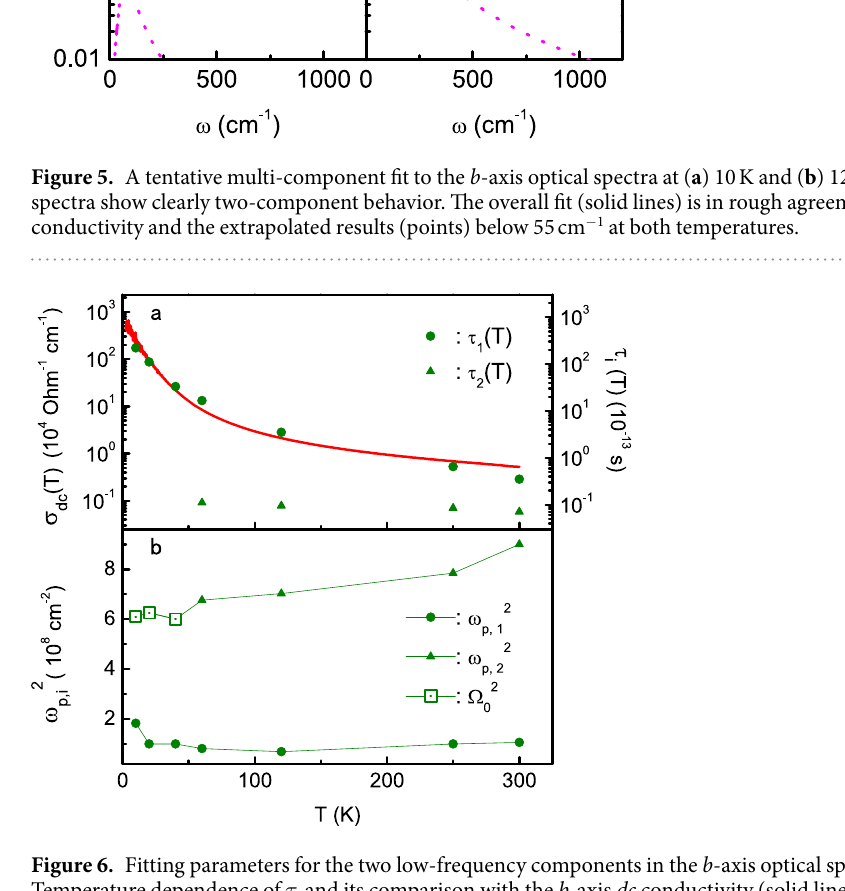
5 SCIeNtIfIC REPORTS | 7: 14178 | DOI:10.1038/s41598-017-14648-7